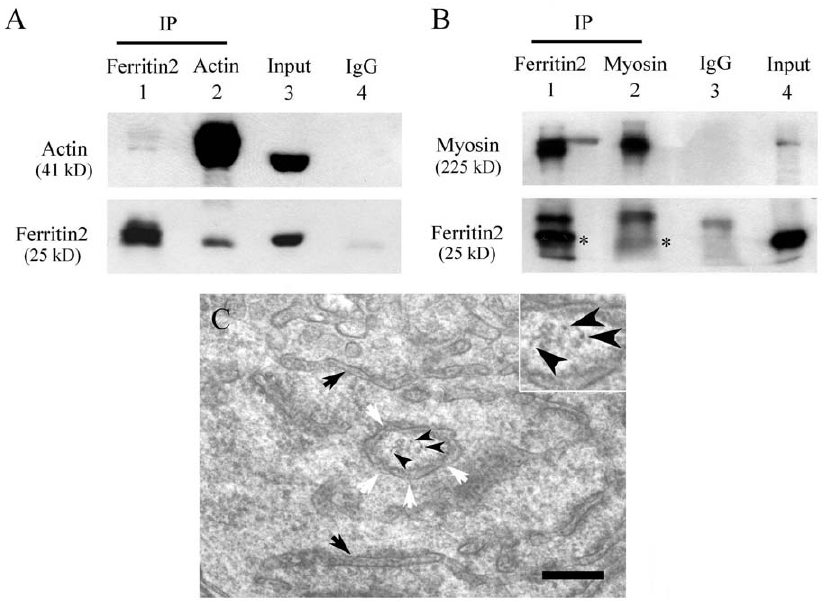
Figure 4. Co-immunoprecipitation assay and TEM image during the formation of an IDV. (A) Co-immunoprecipitation assay for actin and ferritin 2. Lanes 1–4: (1) IP with anti-ferritin 2 antibody; (2) IP with anti-actin antibody; (3) cell lysate input control; (4) IP with control mouse or rabbit IgG. (B) Co-immunoprecipitation assay for myosin and ferritin2. Lanes 1–4: (1) IP with anti-ferritin 2 antibody; (2) IP with anti-myosin antibody; (3) IP with control mouse or rabbit IgG; (4) cell lysate input control. * shows ferritin 2. (C) The formation of an IDV in worker bees on the second day after eclosion. The IDV derived from the fusion of fragments of SER. Inset shows magnified micrograph. Black arrow: SER. White arrow: the fusion gap of fragments of SER during IDV formation. Arrowhead: 7.5-nm diameter spherical iron particles. Scale bar, 200 nm.